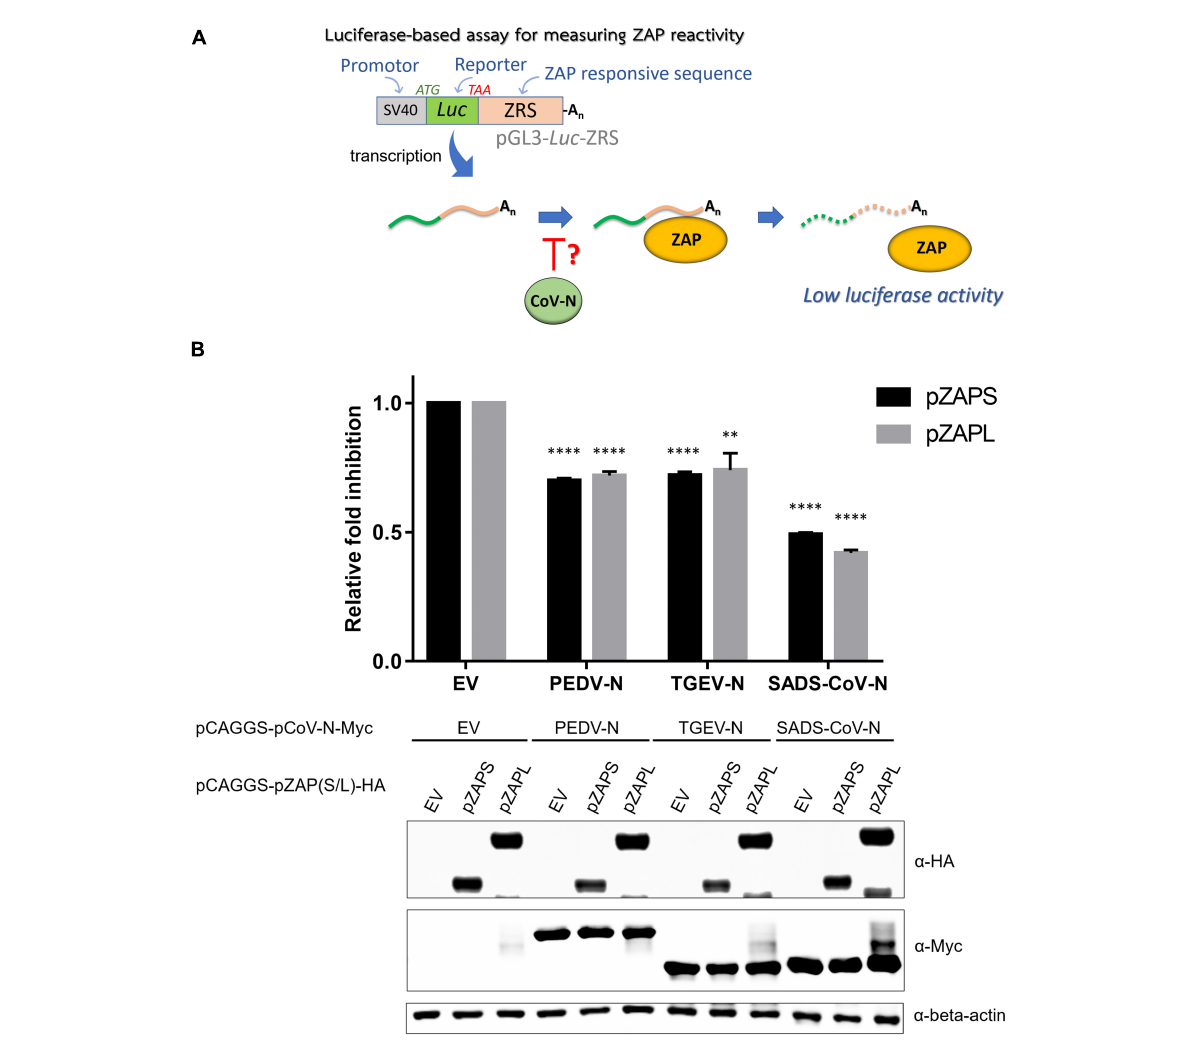
FIGURE6 Nucleocapsid proteins of porcine alpha-coronaviruses suppress the function of porcine cell-derived zinc-finger antiviral protein (ZAP). (A) Schematic representation of the procedure of a luciferase-based assay to measure the activities of pZAPL and -S in the presence of the various pCoV-N. (B) To assess the ability of pCoV-N to antagonize ZAP activity, pGL3-Luc-ZRS was co-transfected with pZAPS or -L and the indicated pCoV-N expressing plasmids. A plasmid expressing Renilla luciferase, pRL-TK, was used to normalize transfection efficiency, and an empty pCAGGS vector (EV) was used as a control plasmid. At 48 hpt, cells were lysed, and luciferase activity was measured. Relative fold inhibition is fold inhibition (described in “Materials and methods”) in the presence of the respective pCoV-N divided by fold inhibition of cells with EV. Data shown are the means ± SD of three independent measurements (Student’s t -test, ** p < 0.005, **** p < 0.00005). (Bottom) SDS-PAGE/western blot showing expression of pZAPL in each